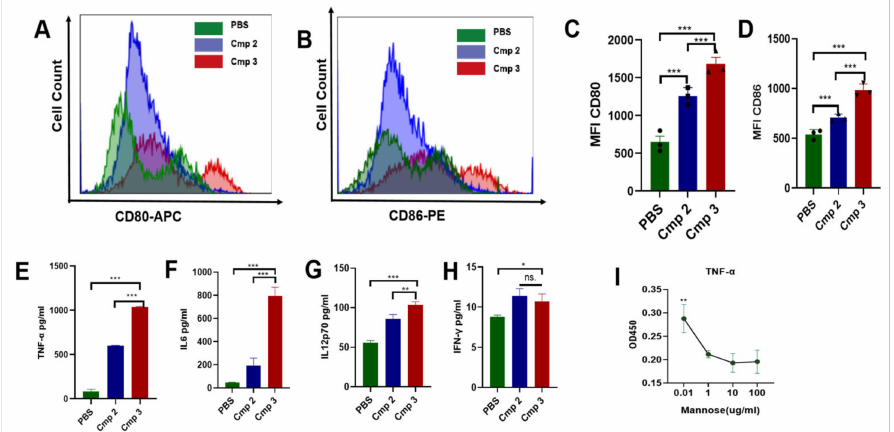
Figure 2. Compound 3 could induce BMDC maturation and stimulate cytokines Secretion. ( A , B ) Maturation of BMDCs was evaluated by measuring the expression of the surface molecules CD80 and CD86 by flow cytometry after 24 h of co-culture with PBS, compound 2 or 3 (5.0 µ M). ( C , D ) The mean fluorescence intensities (MFI) of costimulatory molecules CD80 and CD86. ( E – H ) TNF- α , IL-6, IL12-70, and TNF- γ levels were measured from cell culture supernatants us- ing ELISA. ( I ) TNF- α levels were quantified by ELISA from BMDC culture supernatants treated with 5.0 µ M compound 3 and different concentrations of mannose. Significant differences among